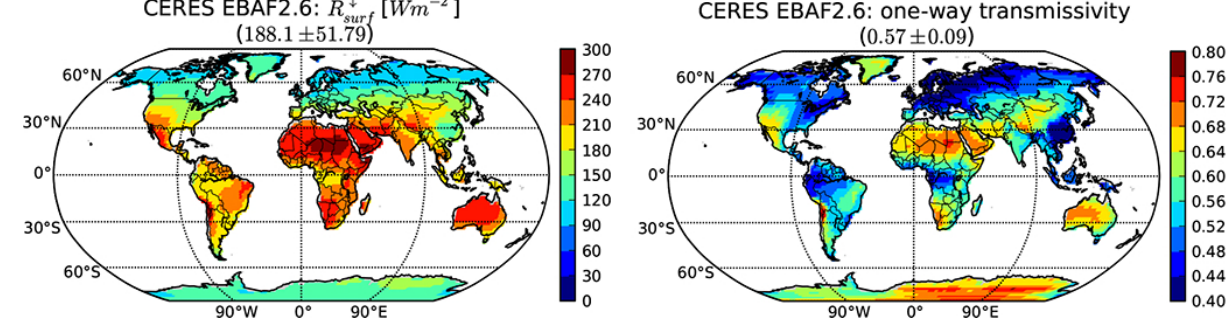
Fig. A4. CERES EBAF2.6 surface (left) solar radiation flux and calculated one-way atmospheric transmissivity